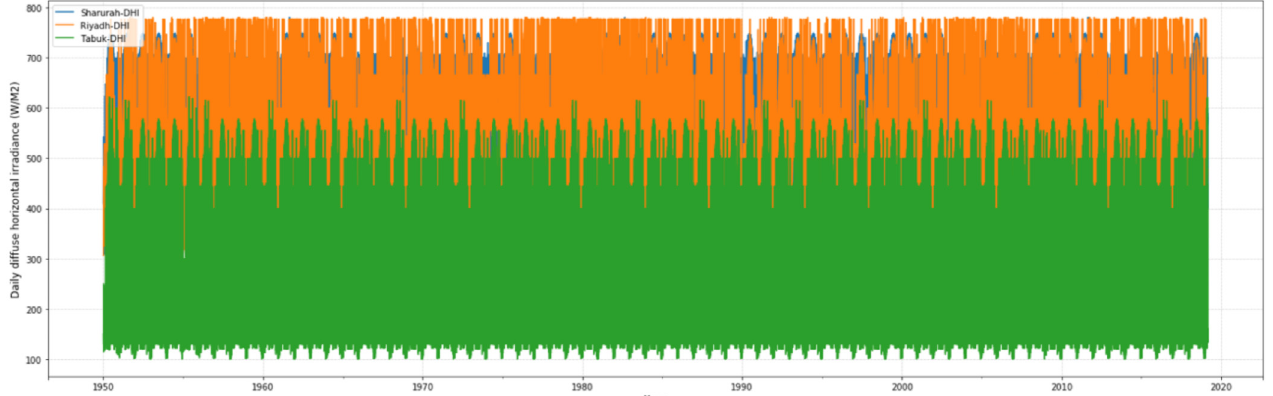
Fig. 7. The diffuse horizontal irradiance (DHI) performance of the three regions from 1950 to 2020 [9]. The lowest line is 100 Wm (cid:1) 2 and the highest line is 800 Wm (cid:1) 2 . The highest DHI is in Riyadh and the lowest is in